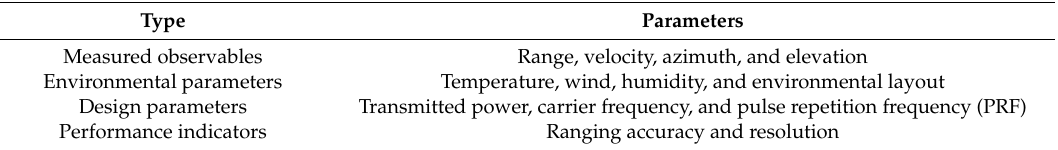
Table 3. Ranging parameters